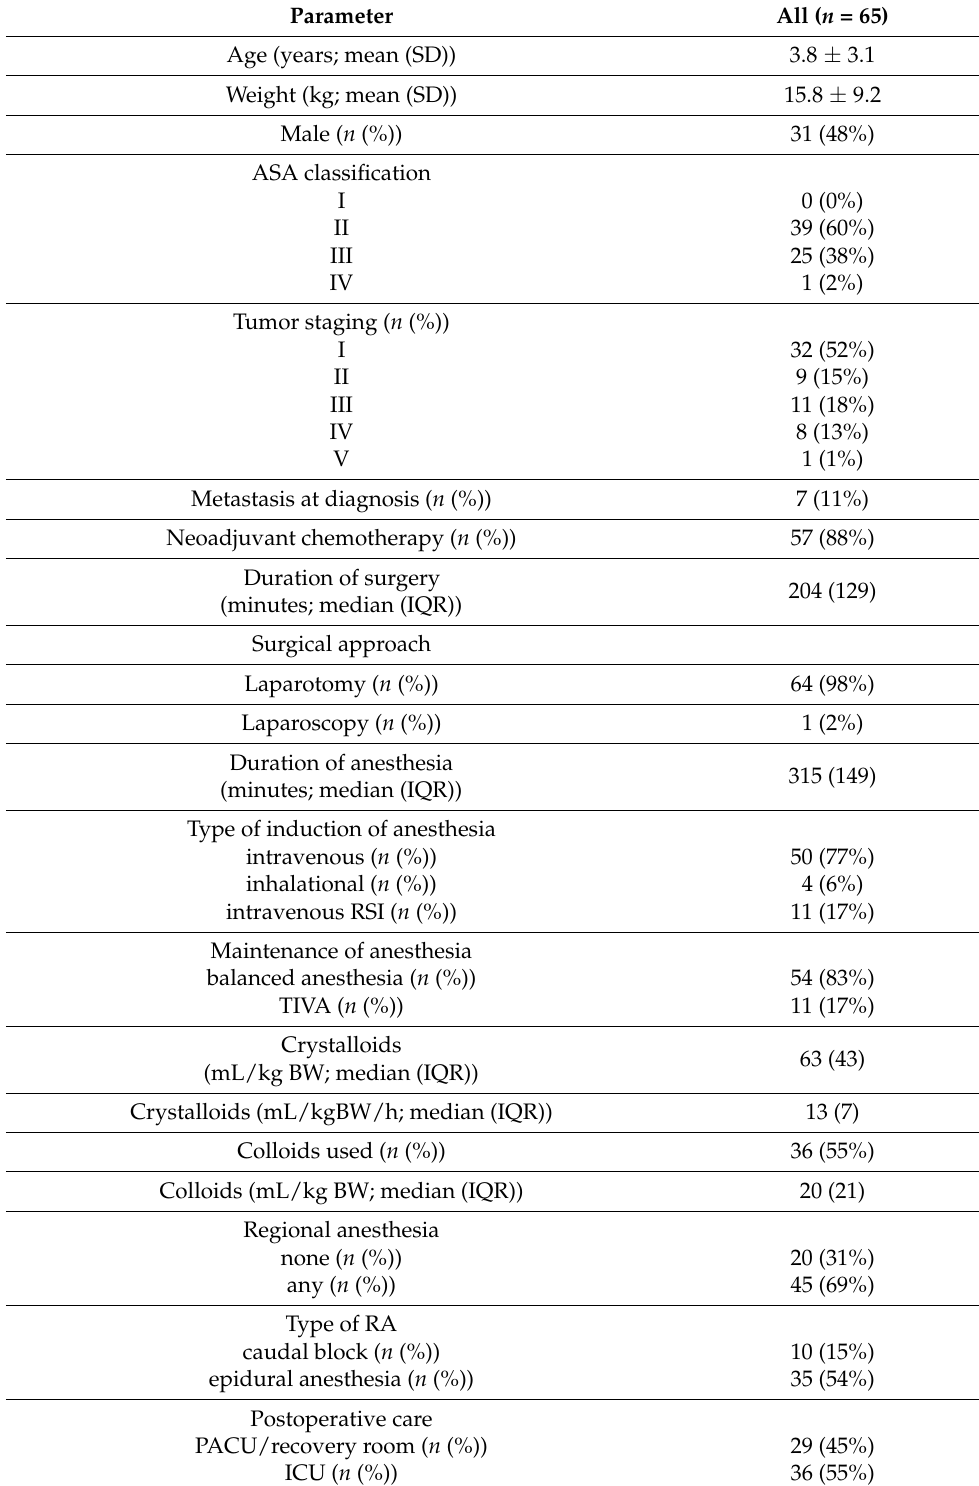
Table 1. Baseline characteristics of all patients. SD = standard deviation; ASA = American Society of Anesthesiology; IQR = interquartile range; RSI = rapid sequence induction; TIVA = total intravenous anesthesia; RA = regional anesthesia, PACU = post-anesthesia care unit, ICU = intensive care